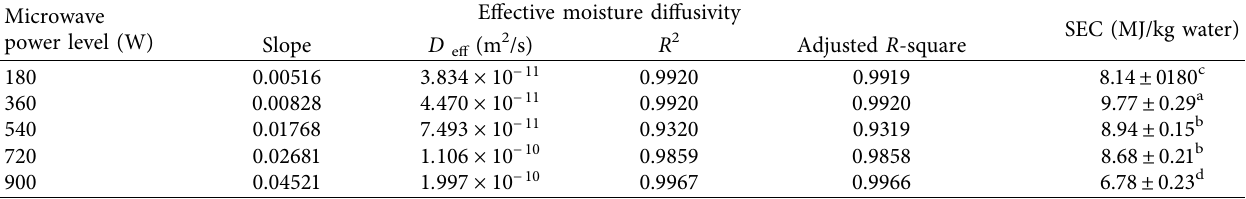
Table 2: Calculated efective moisture difusivity values and specifc energy consumption for microwave drying of Stevia leaves. Microwave